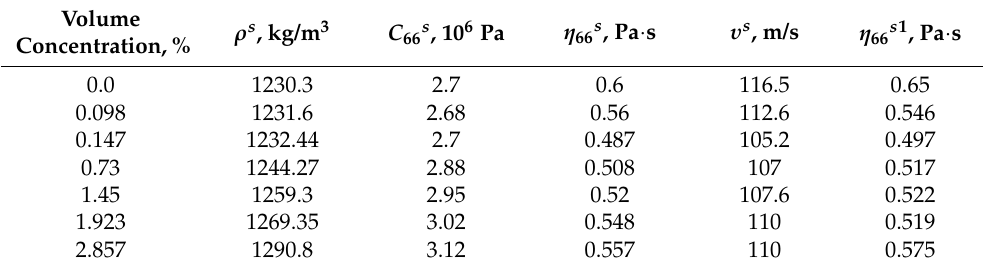
Table 3. The obtained values of the material constants and shear acoustic wave velocity for the suspension samples at different volume concentrations of synthetic diamond particles.